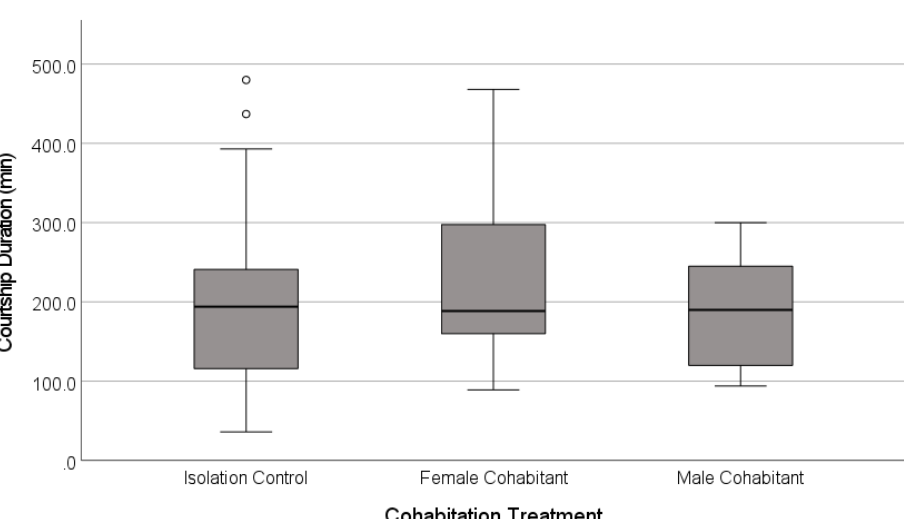
Figure 4. Latency to the first copulation in the laboratory mating trials for adult females that had experienced one of three social contexts during their final juvenile instar. The females were held in isolation, or were exposed to airborne, vibrational and direct tactile cues from juvenile female or adult male cohabitants. The boxplots show the medians (solid line), the range between the first and third quartiles (inter-quartile range, IQR, box), the maximum and minimum values excluding outliers (whiskers), and potential outliers (open circles, 1.5 – 3x IQR above the third quartile). Table 2. Results of generalized linear model analyses examining the effects of the focal females’ cohabitation treatment on the outcome of successful mating trials, including the latency to copulation (A), the copulation frequency (B), the occurrence of premature cannibalism that terminated the mating (C), and the frequency of successful plug placement (D). Model Variables